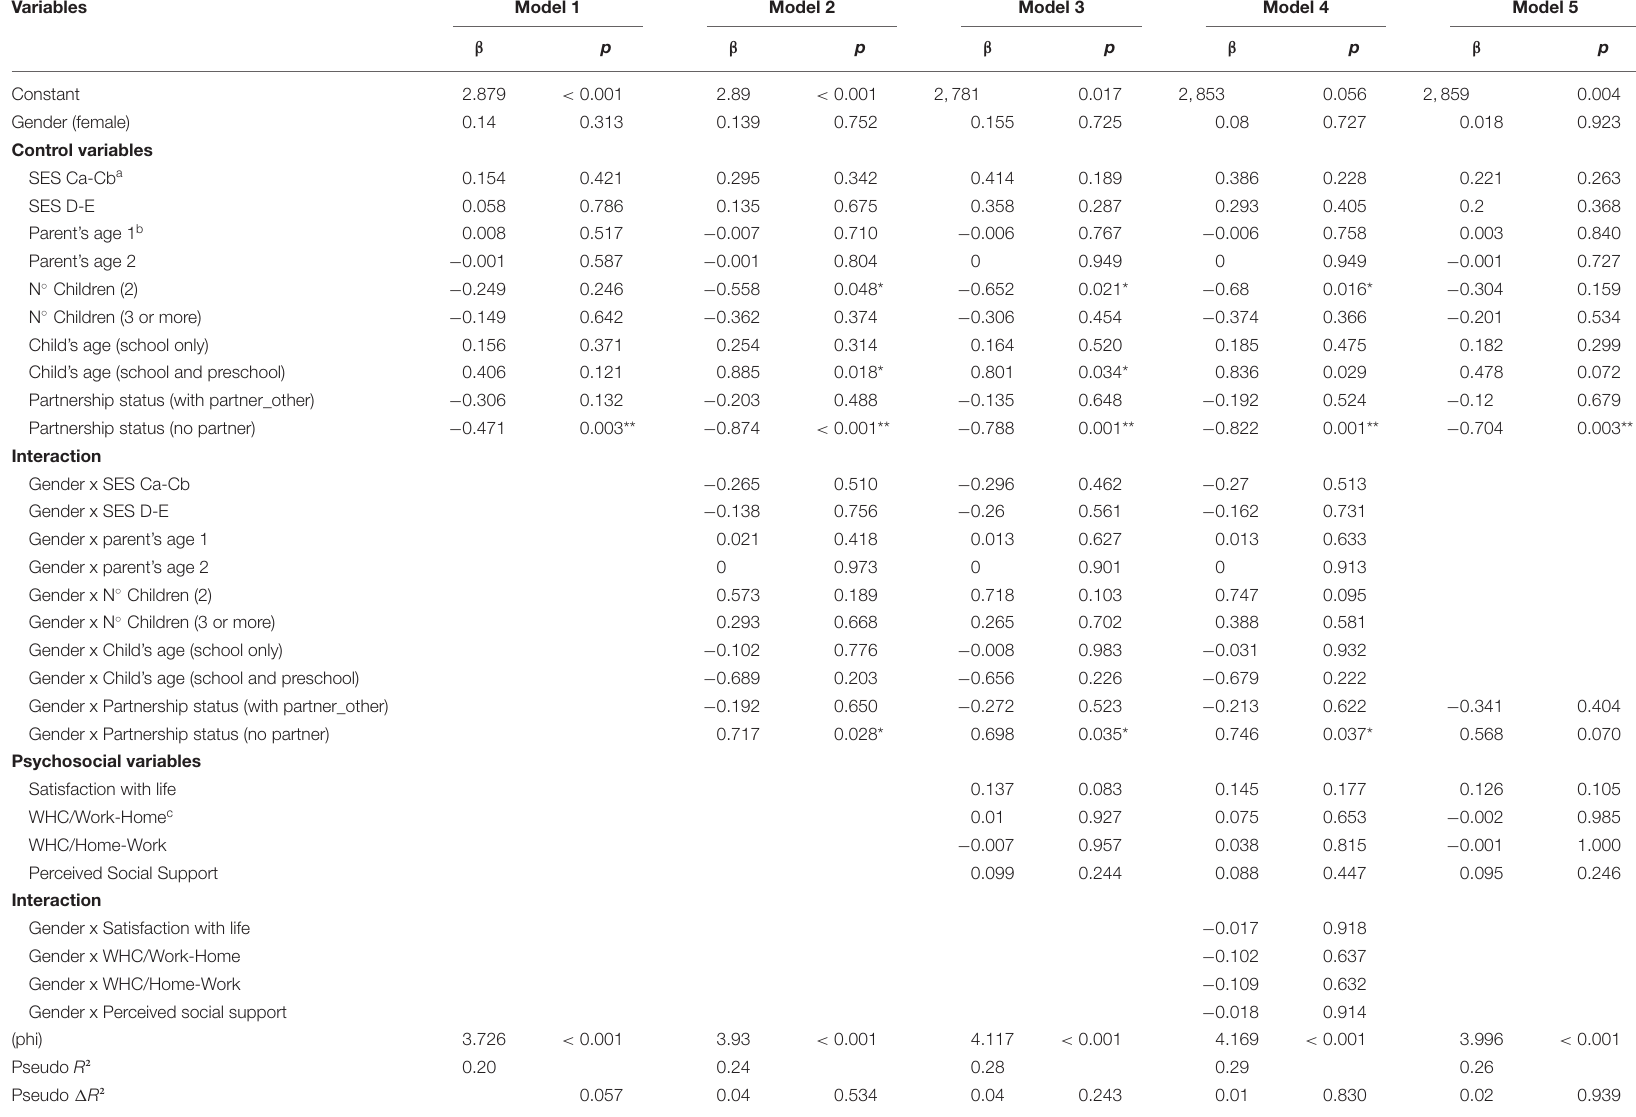
TABLE 4 | Beta regression analysis of parental